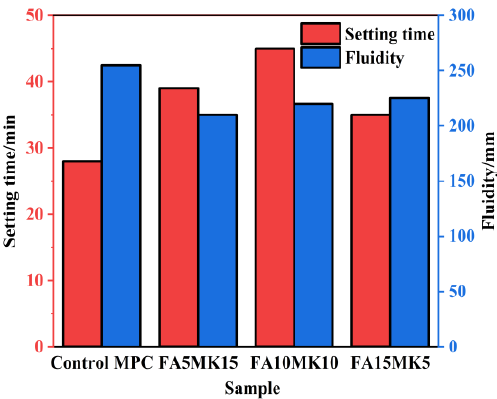
Figure 5. The fluidity and setting time of MPC pastes with compound powder.